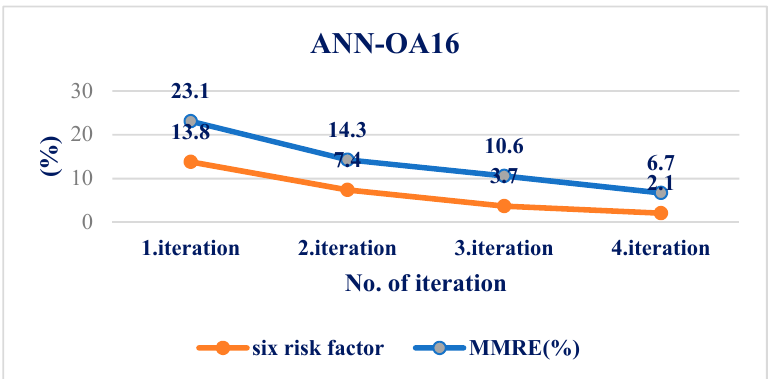
Figure 10. Influence of six factors on the resulting risk and error of the ANN-OA16 model through four iterations.